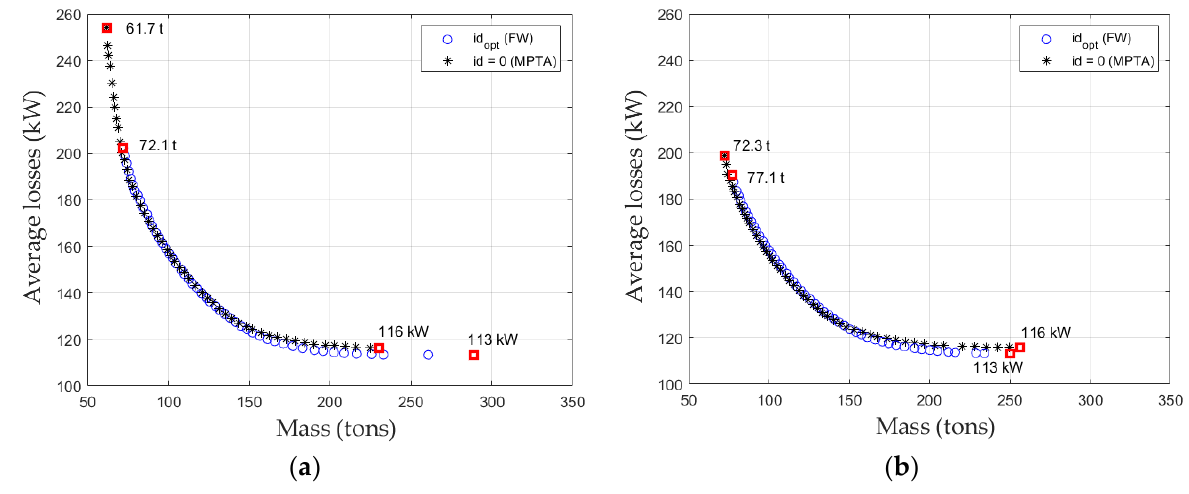
Figure 7. Pareto-optimal front of optimal machines for 𝑞 = ( a ) and 𝑞 = 5 ( b